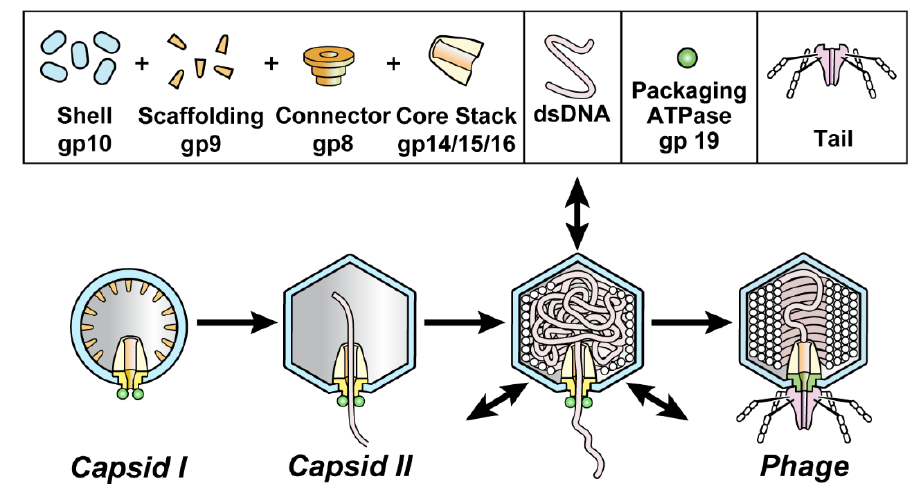
Figure 1. DNA packaging of the related phages, T3 and T7. Capsid I (left image) is assembled and then starts to package DNA while converting to capsid II (next image) and ultimately becomes a phage particle capsid (right image). The particles investigated here are dynamic capsid II expansion products that potentially mature to become capsids of phages; arrows in the third image from the left indicate expansion / contraction dynamism. Although pictured here as intermediates, intermediate status not been biochemically demonstrated for particles generated by shell dynamism. A detailed hypothesis is in reference 12.